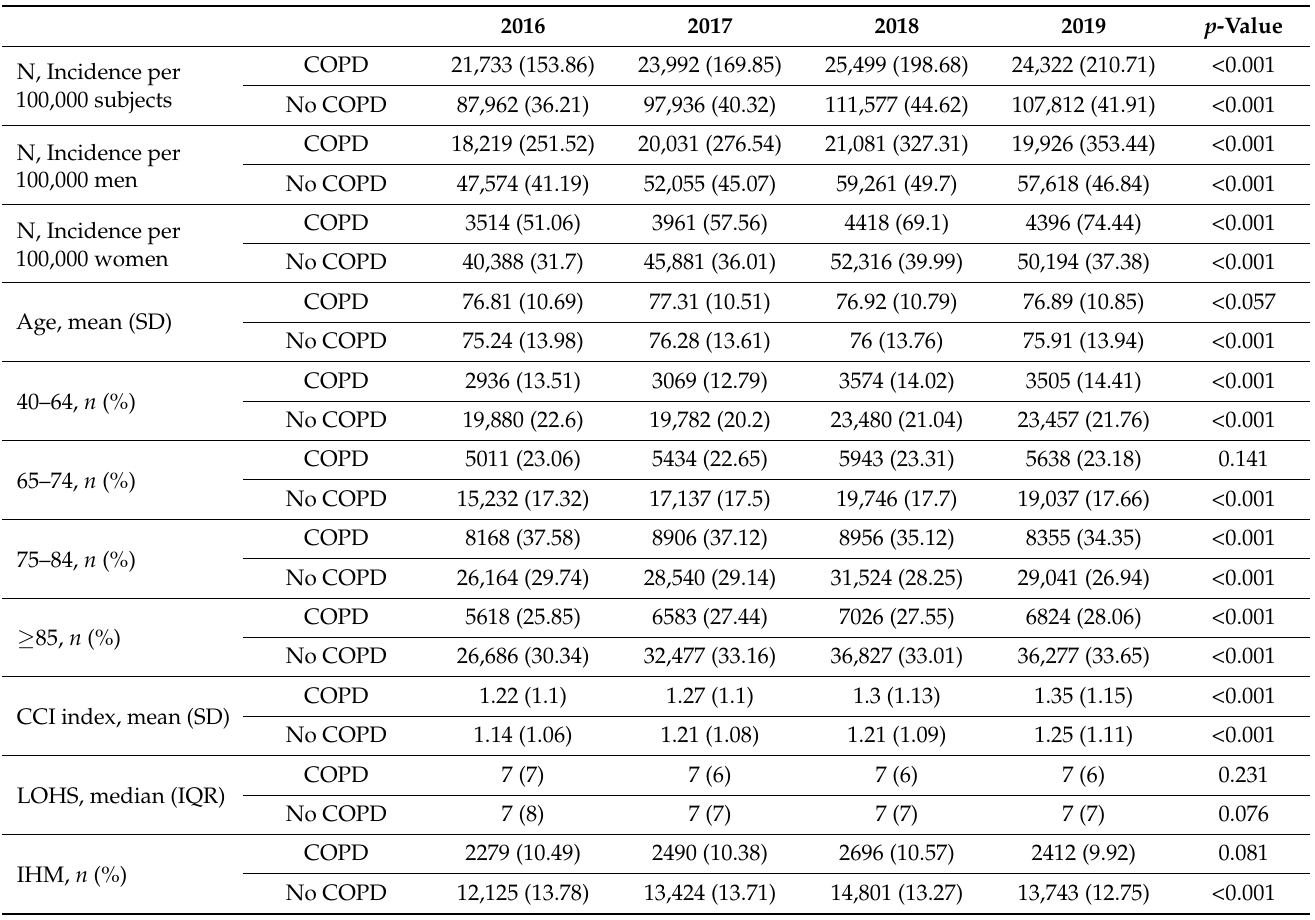
Table 1. Trends in the incidence, age distribution, Charlson comorbidity index, and hospital outcomes for patients admitted to Spanish hospitals from the year 2016 to 2019 with community-acquired pneumonia according to presence of chronic obstructive pulmonary